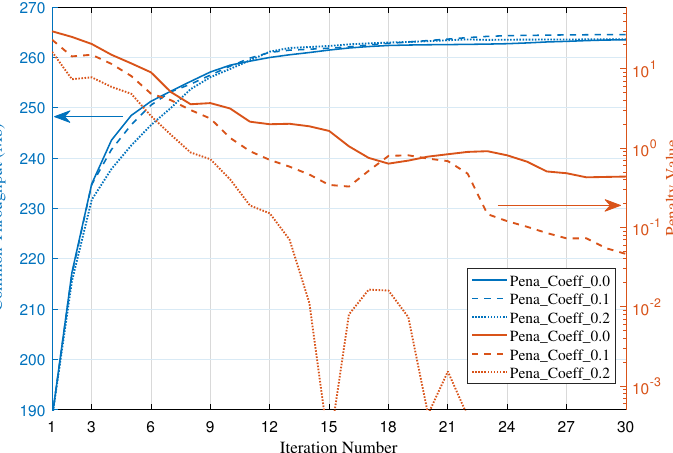
Figure 7. Convergence results of the proposed algorithm with different penalty